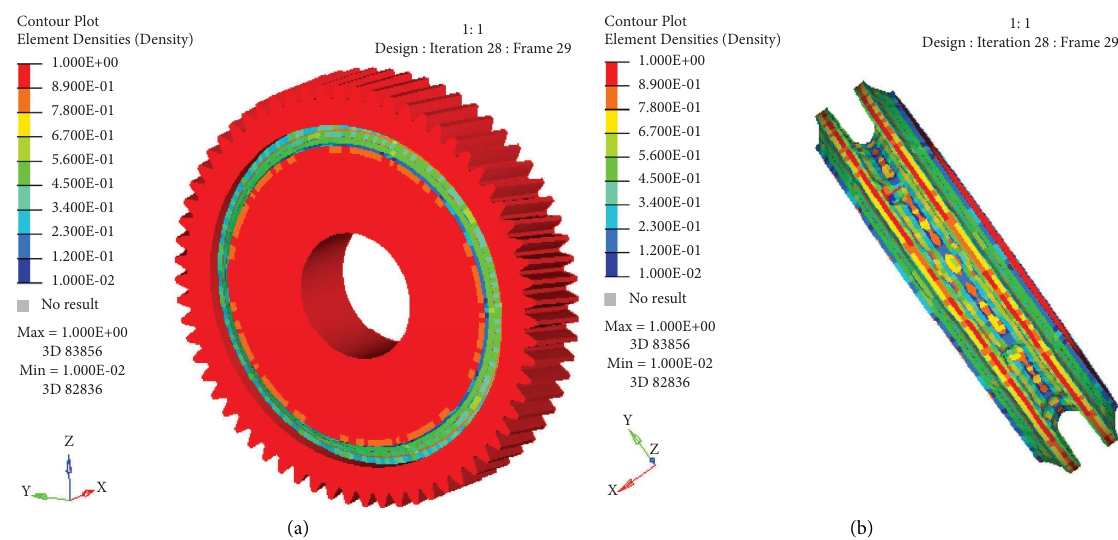
Figure 7: Schematic of gear dynamic topology optimization results. (a) Schematic of topology optimization results. (b) Schematic of design area optimization results.